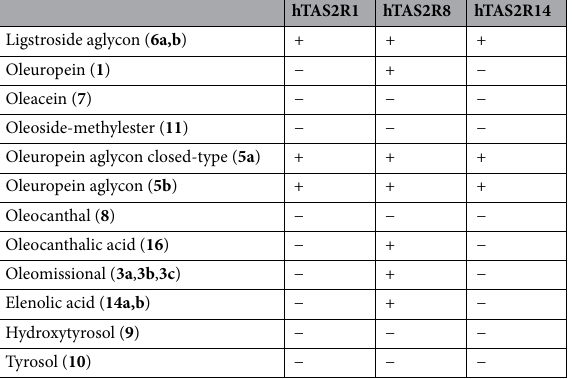
Table1. Summary of the compounds from olive oil and bitter taste receptor activation ( bolded numbers in parentheses identify each compound with the number used in Fig. 1